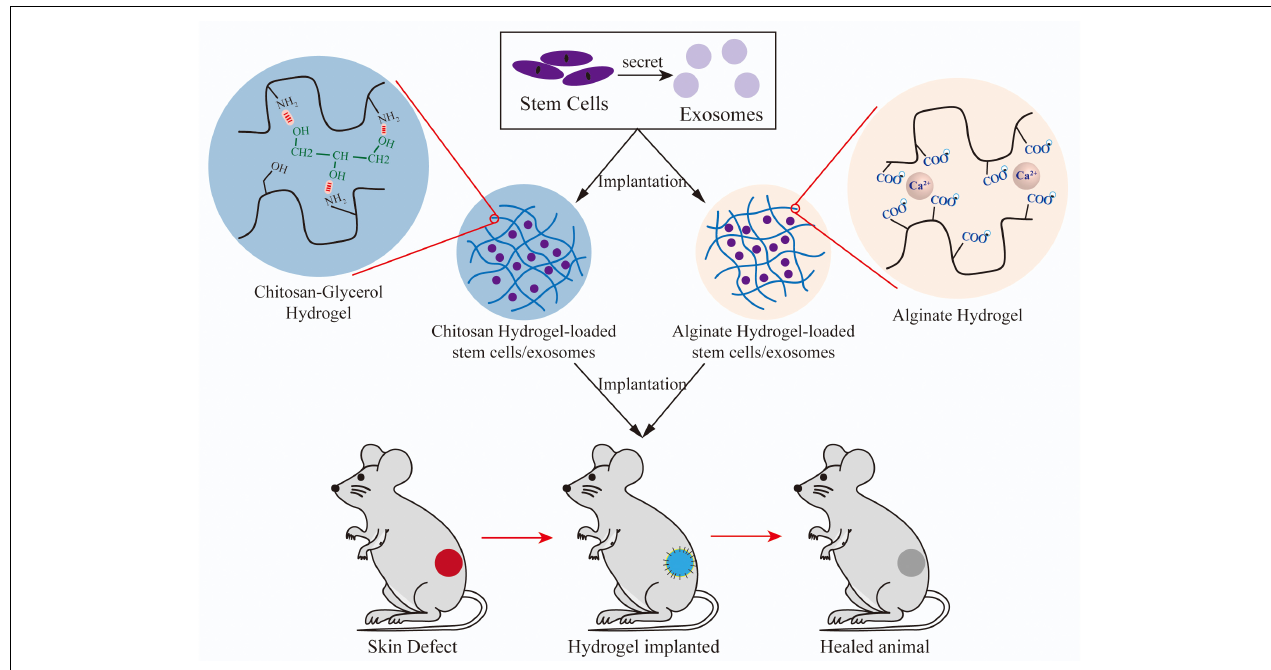
FIGURE 2 | The process of implantation of different hydrogels combined with SCs/exosomes into models of skin defects and wound